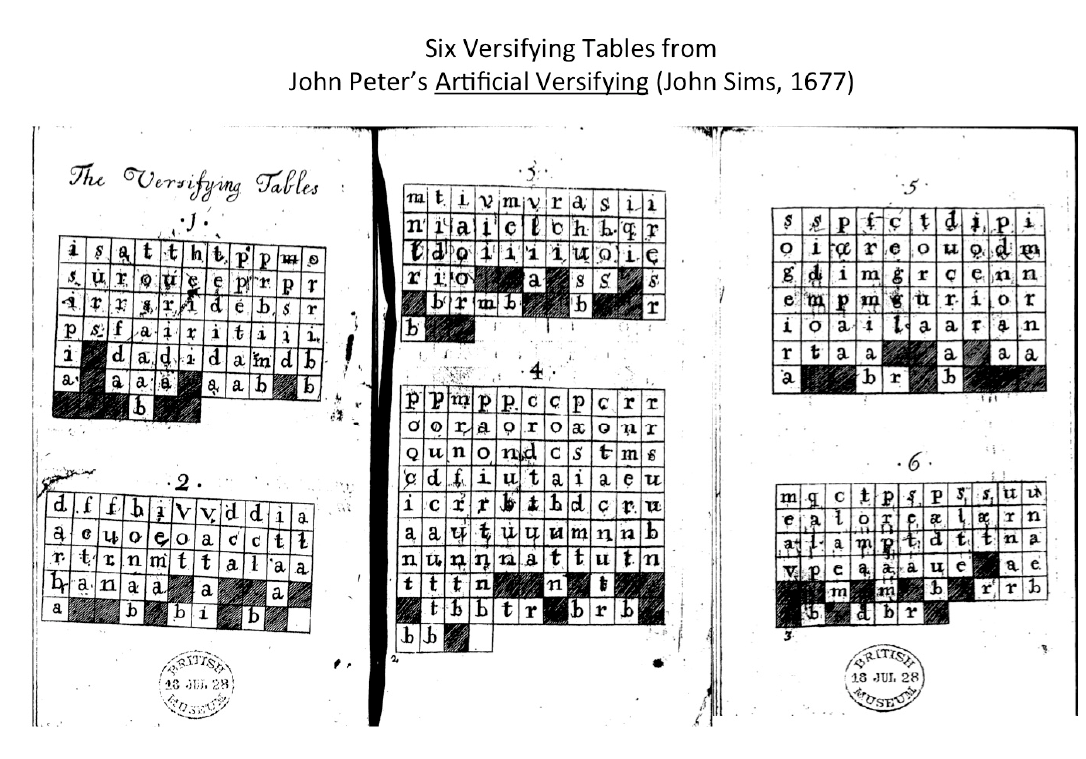
Figure 5. The Six Versifying Tables from John Peter’s Artificial Versifying (John Sims, 1677).